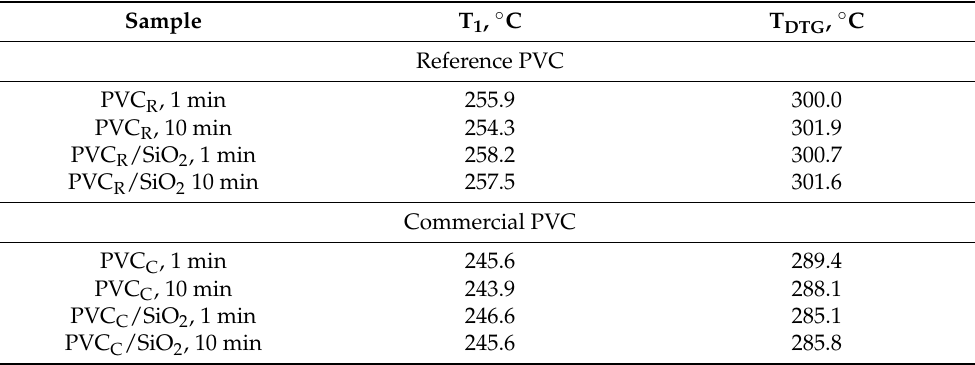
Table 4. The temperature of 1% weight loss (T 1 ) and the temperature of the maximal degradation rate (T DTG ) for the PVC R , PVC R /SiO 2 , PVC C , and PVC C /SiO 2 processed in 1 and 10 min of rolling